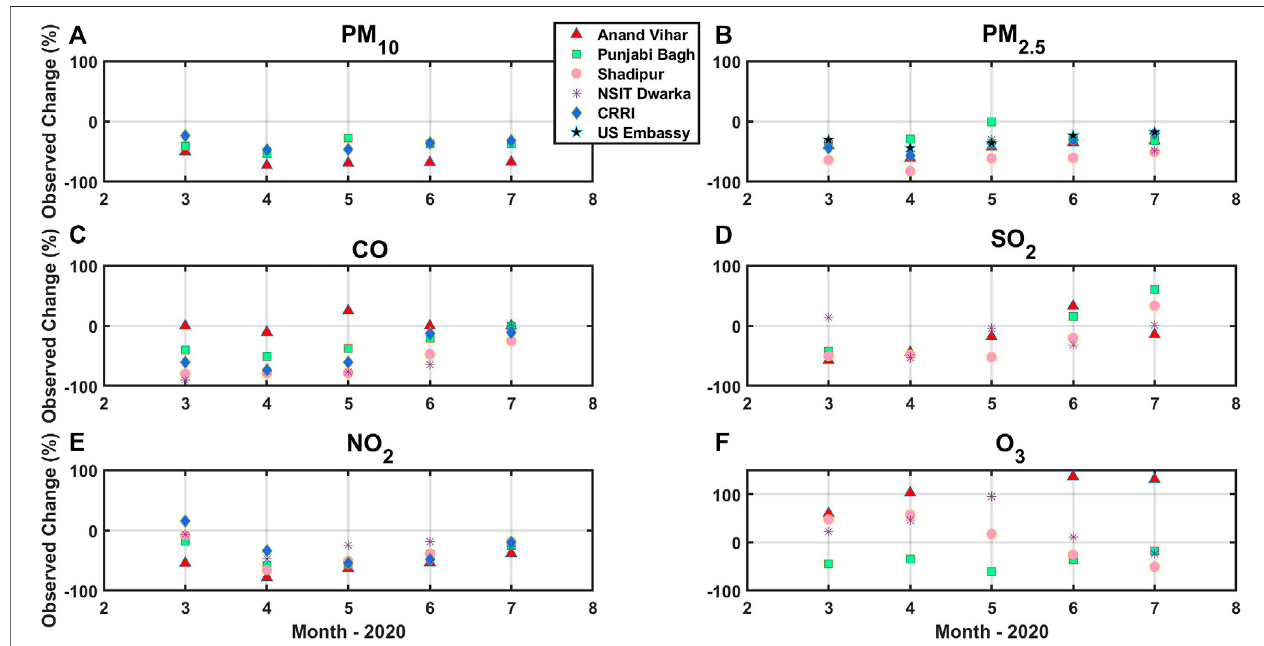
FIGURE9| Percentagechangeinmonthlymeanconcentrationsatvariouslocationswithrespecttotheaverageof2015 – 2019for (A) PM 10 , (B) PM 2.5 , (C) CO, (D) SO 2 , (E) NO 2 , (F) O 3